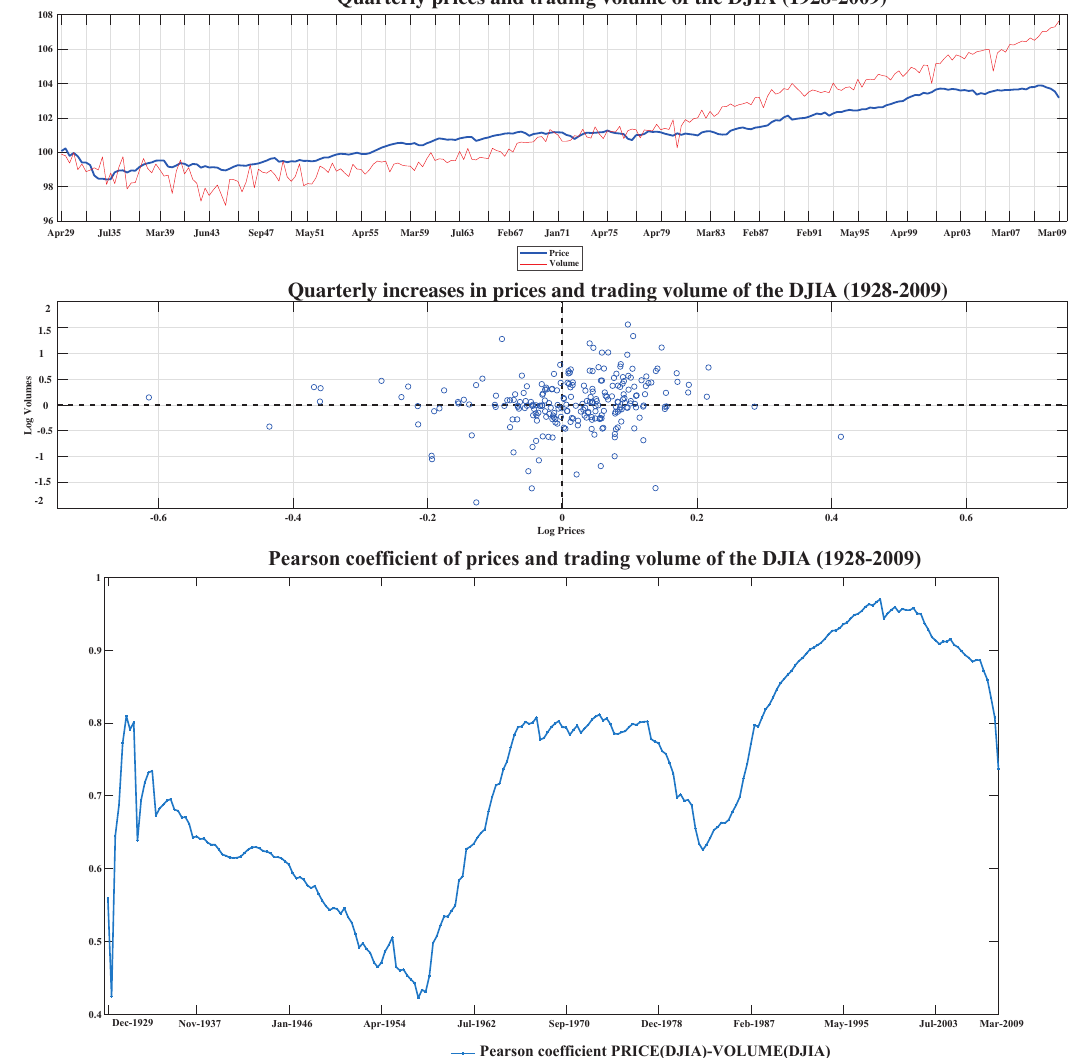
Figure 1. Three different representations of DJIA price-volume evolution and variability during the period 1928–2009. Source: Own